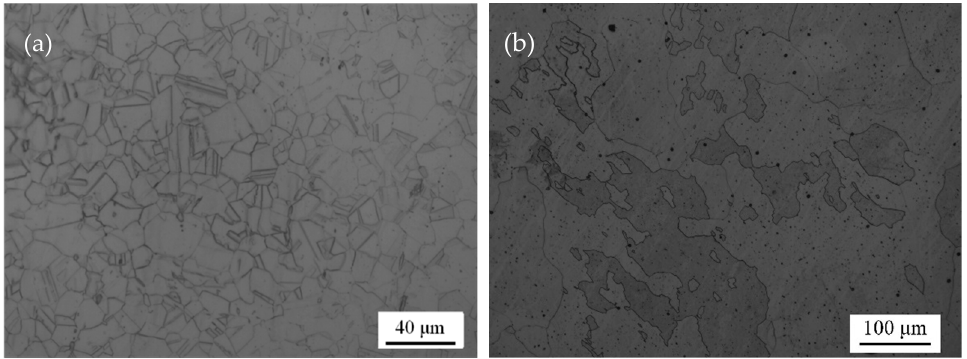
Figure 3. Metallographic image:( a ) as-received SS304; and( b ) as-cast SS304.